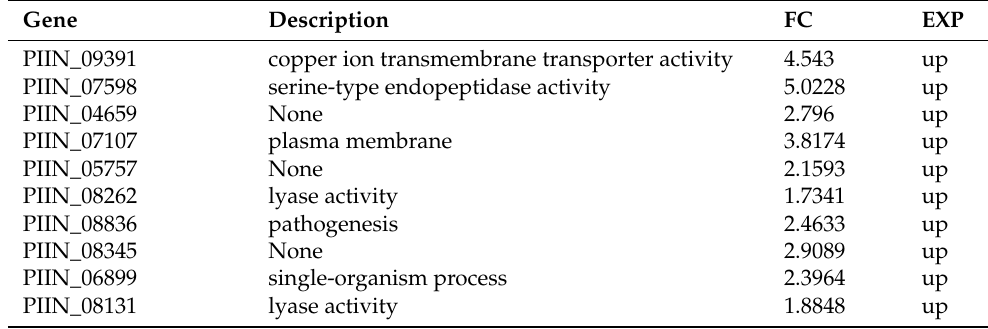
Table 3. P. indica differentially expressed genes (DEGs) during colonization (7 dai vs. 3 dai).